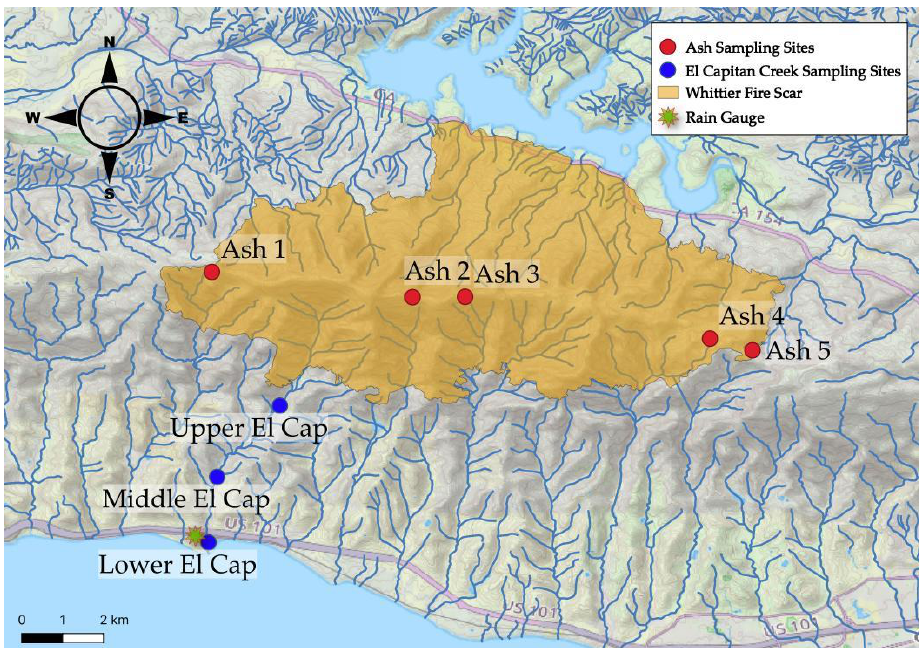
Figure 1. Whittier Fire and sampling locations. The Whittier Fire scar is represented by the orange shaded region [35]. Ash 1 was sampled at 34°31′57.0″ N, 120°01′17.0″ W; Ash 2 at 34°31′32.9″ N, 119°58′04.8″ W; Ash 3 at 34°31′33.2″ N, 119°57′14.4″ W; Ash 4 at 34°30′53.3″ N, 119°53′19.7″ W; and Ash 5 at 34°30′42.1″ N, 119°52′39.0″ W. Upper El Cap is located at 34°29′49.2″ N, 120°00′11.9″ W, ~0.7 km downstream from the fire perimeter, with a subcatchment area of 8 km 2 . Middle El Cap is located at 34°28′41.2″ N, 120°01′12.0″ W, ~3 km downstream from the fire perimeter, with a subcatchment area of 14 km 2 . Lower El Cap is located at 34°27′38.5″ N, 120°01′20.3″W, ~5 km downstream from the fire, with a subcatchment area of 16 km 2 . Fire perimeter data from [34]. The base map for Figure